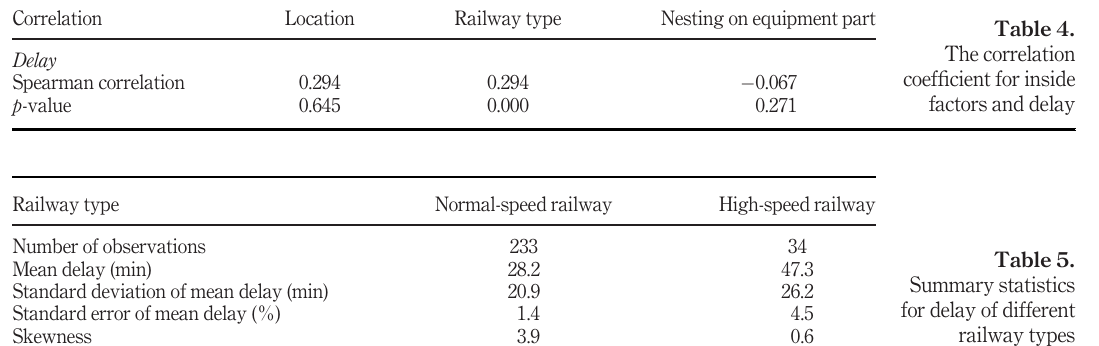
Table 4. The correlation